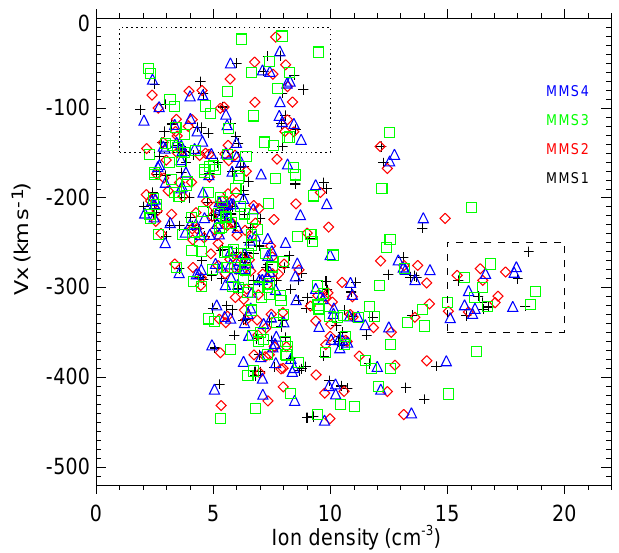
Figure 2. A scatter plot of V X versus ion density from all four MMS spacecraft from 19:52:00 to 20:05:00UT. The data points inside the dotted and dashed box present the magnetosphere and magne- tosheath ions,